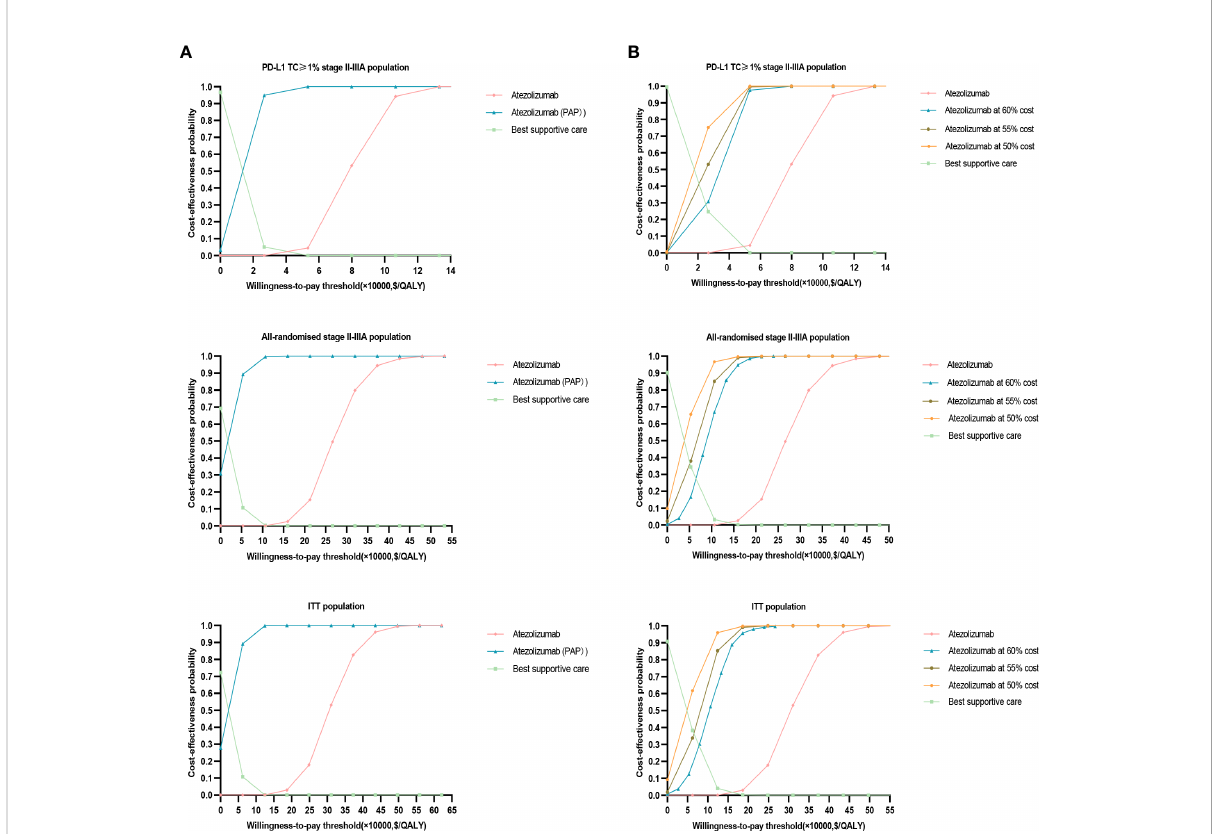
FIGURE 4 Probability sensitivity analysis acceptance curve. (A) When PAP is applicable, the probability sensitivity analysis of atezolizumab versus best supportive care in the PD-L1 TC ≥ 1% stage II – IIIA group (SP263), all stage II – IIIA groups, or the intention-to-treat group (stage IB – IIIA) can be compared with the acceptable curve. Atezolizumab, atezolizumab without PAP; Atezolizumab (PAP), atezolizumab after PAP strategy; Best supportive care, whether best supportive care of PAP is performed or not. (B) Probability sensitivity analysis of atezolizumab after price reduction versus best supportive care in the PD-L1 TC ≥ 1% stage II – IIIA group (SP263), all stage II – IIIA groups or the intention-to-treat group (stage IB – IIIA) can be compared with the acceptable curve. Atezolizumab, atezolizumab at 100% cost; Best supportive care, best supportive care at 100%